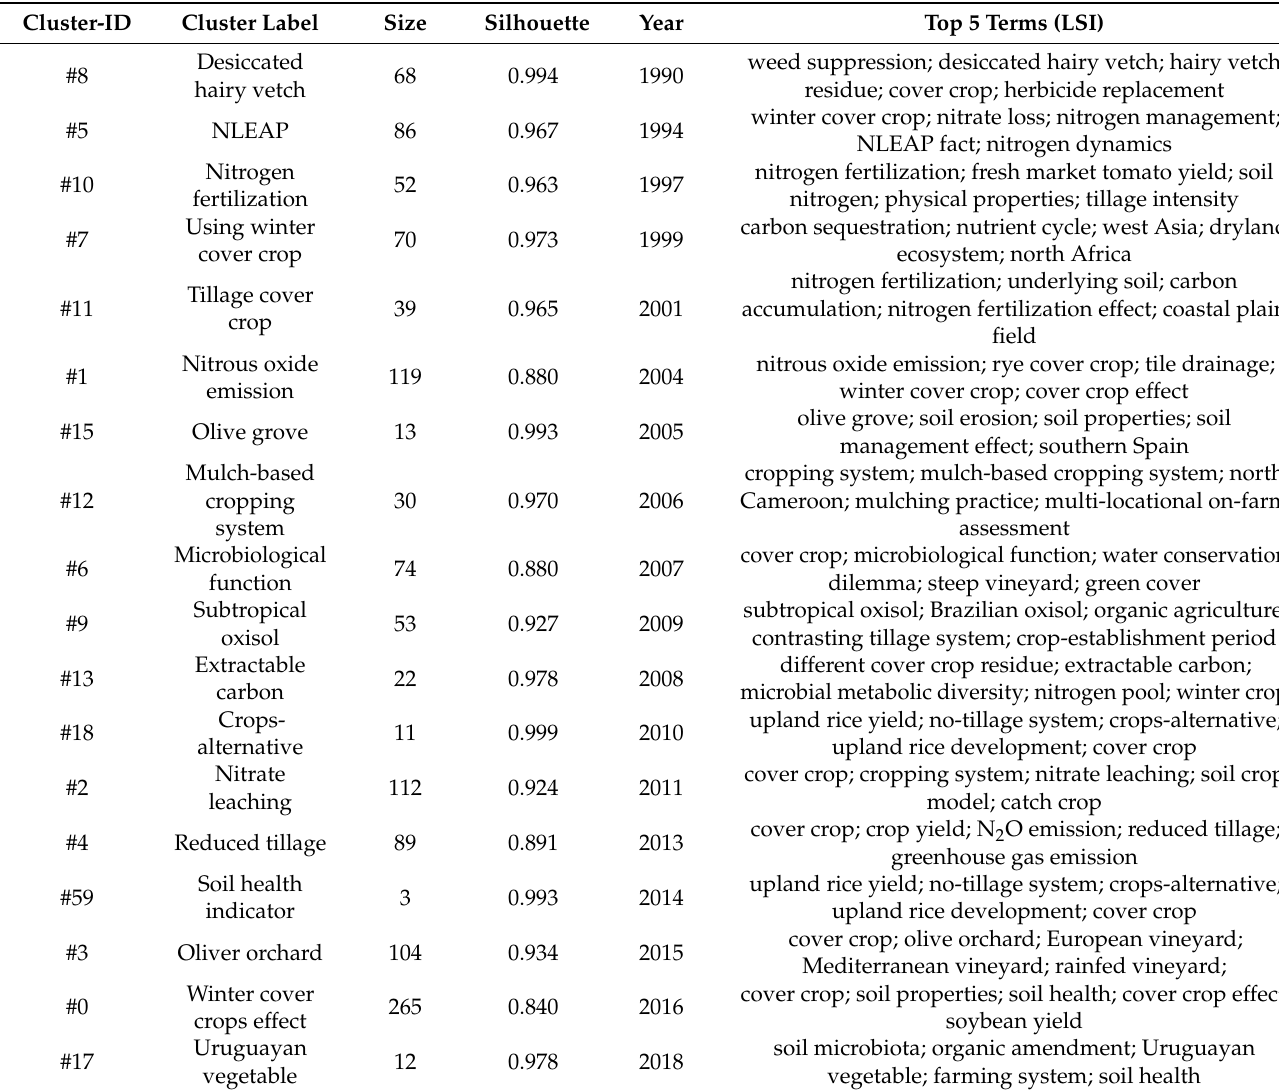
Table 5. Top 5 terms in citation-clustering